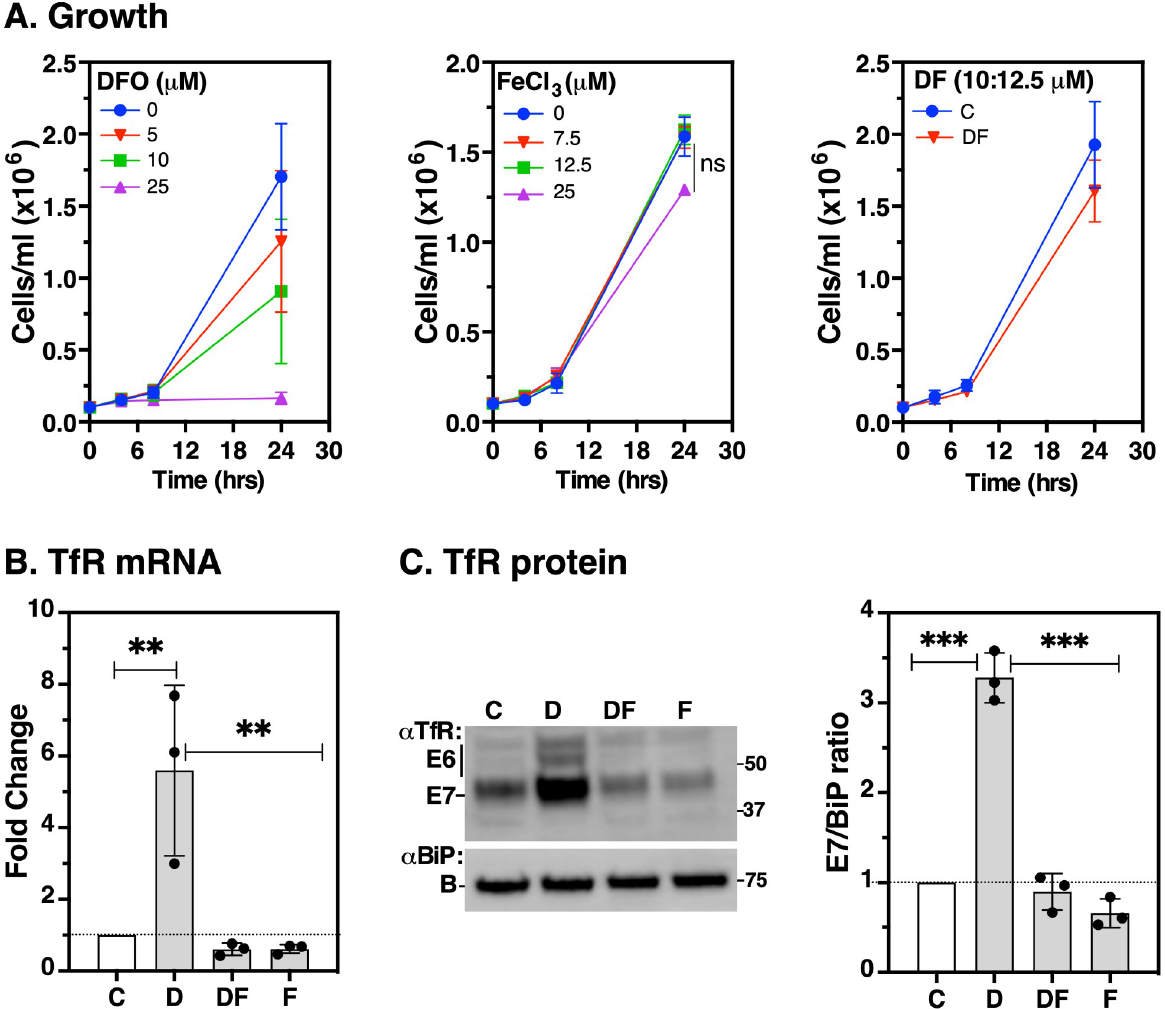
Fig 1. Effect of deferoxamine or ferric iron on cell viability and TfR expression. Log phase BSF cells (~5x10 5 cells/ml) were incubated with the iron chelator deferoxamine (DFO, D), iron-saturated deferoxamine (DF), Iron (III) chloride (FeCl 3 , F) or untreated (C). A . Cell densities (mean ± SD, n = 3) were determined by haemocytometer in the presence of varying concentrations of DFO, FeCl 3 or DF as shown in the insets; ns: not significant. B . RNA was harvested from cells following 5 hr treatments with D (25 μ M); DF (25:27.5 μ M); F (25 μ M) or untreated (C). TfR mRNA levels were determined by qRT-PCR normalised to ZFP3 signal and expressed as a ratio to the control treatment values. Data are means ± SD ( n = 3 biological replicates; with 3 technical replicates for each n ). �� P < 0.002, as determined by one-way ANOVA with post-hoc Tukey test. C . Protein levels were detected by immunoblotting with anti-TfR ( α TfR) or anti-BiP ( α BiP) as loading control. Bar chart (right) shows signals of E7 from α TfR immunoblot quantified by densitometry using Image Lab software (Bio-Rad) normalised to the corresponding BiP signals. Data are means ± SD ( n = 3 biological replicates). ��� P < 0.001, as determined by one-way ANOVA with post-hoc Tukey